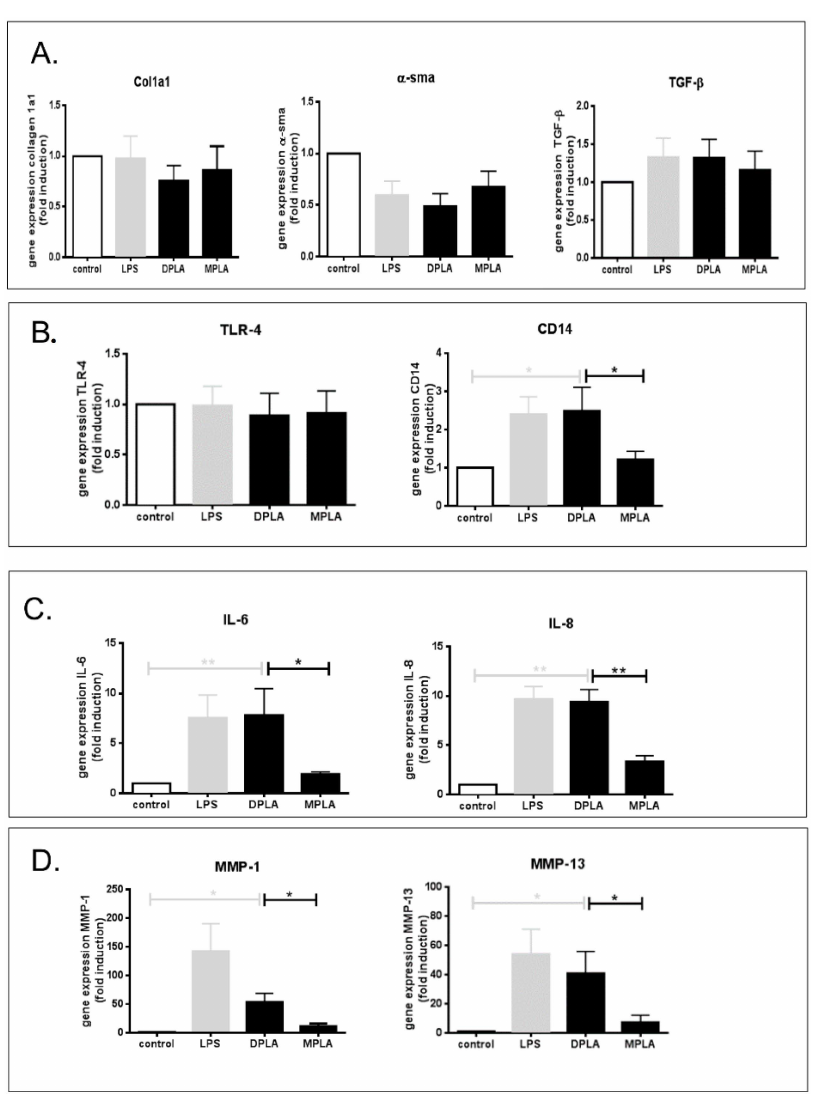
Figure 2. E ff ects of wild-type LPS, di-phosphoryl lipid A (DPLA), and mono-phosphoryl lipid A (MPLA) on gene expression levels in cultures of primary rat hepatic stellate cells (HSCs). ( A ) E ff ects of LPS, DPLA, and MPLA on mRNA levels of the fibrogenic parameters Collagen 1a1, α SMA, and TGF β . ( B ) E ff ects of the bacterial toxins on mRNA levels of the LPS receptors TLR-4 and CD14. ( C ) E ff ects on mRNA levels of the proinflammatory mediators IL-6 and IL-8. ( D ) E ff ects of the bacterial toxins on mRNA levels of MMP-1 and MMP-13. LPS (from E. coli ) serves as positive control (* = p < 0.05; ** = p < 0.01; n = 5 per